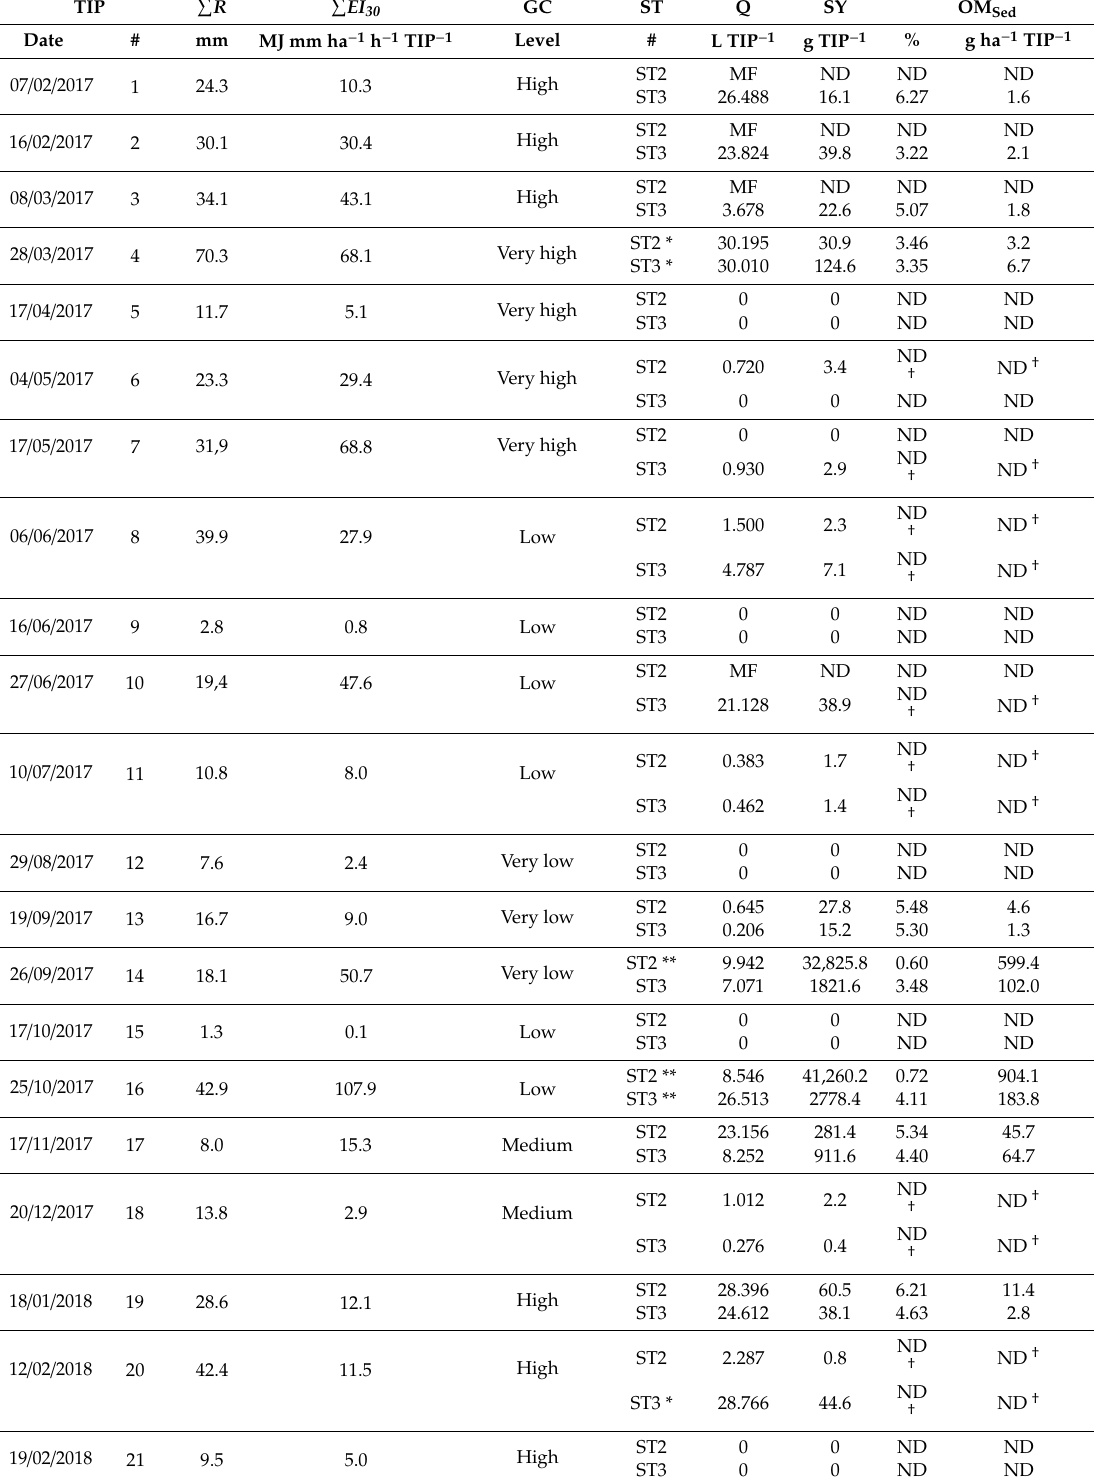
(cid:80) (cid:80) R ) and erosivity ( EI 30 ) calculated with the synthetic weather Table 2. Accumulated rainfall depth ( station, runo ff ( Q ) and sediment (SY) yields, and organic matter content measured in the sediment (OM Sed ) collected in the two sediment traps (ST) at each time-integrated period (TIP) during the 15-month test